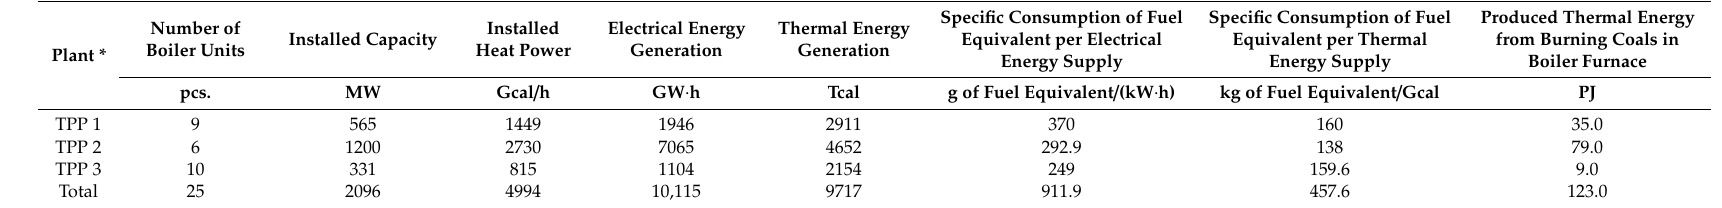
Table 8. Characteristics of typical coal-fired thermal power plants (TPPs) in each of three